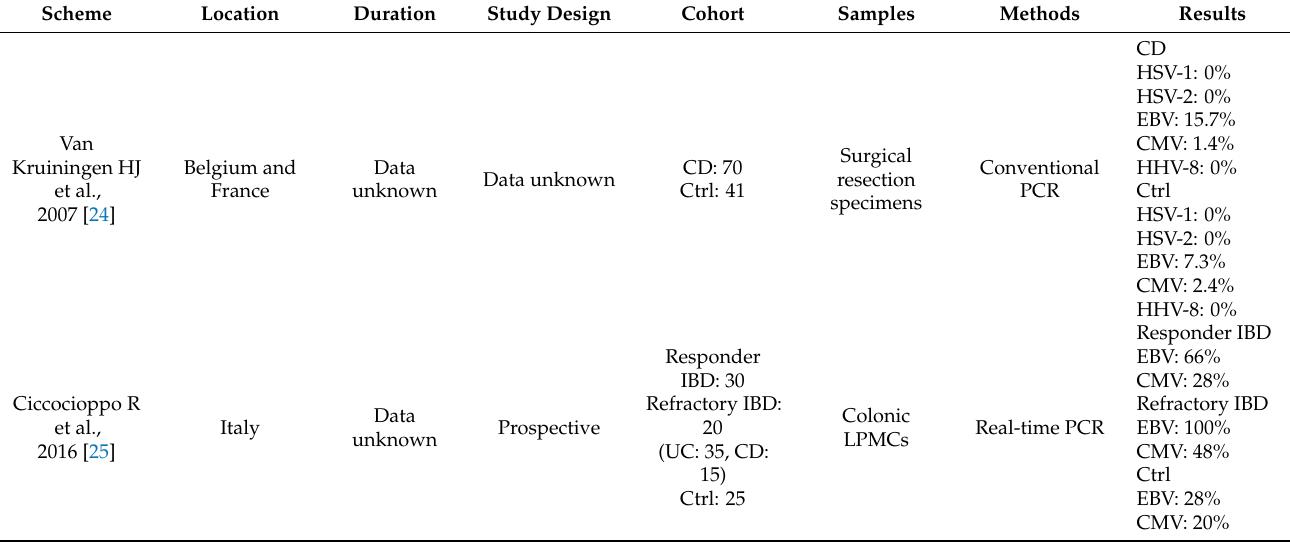
Table 1. Prevalence of human herpesvirus DNA in colonic mucosa of patients with inflammatory bowel disease.